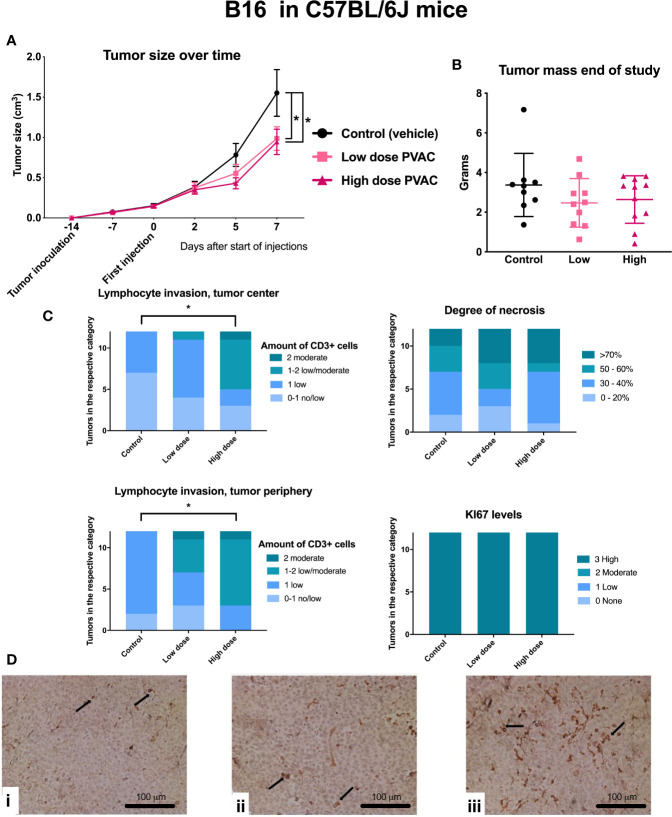
C57BL/6J mice were inoculated with B16.F10 tumor cells and subsequently intratumorally treated with polyvinyl alcohol carbazate (PVAC) (either low dose 0.5 mg/ml or high dose 10 mg/ml) or vehicle. (A) Injections performed on days 0, 2, 5, and 7. Five days after the first injection, tumor size was smaller in the high dose PVAC group compared to control (p < 0.05 mean 0.34 cm3, CI 95% 0.01–0.69). On day 7 the tumor size was smaller in both low dose and high dose PVAC groups (p < 0.05 mean 0.6 cm3 CI 95% 0.27–0.95 and p < 0.05 mean 0.57 cm3 CI 95% 0.22–0.92 respectively). (B) Shows tumor mass at the end of the study after tumor excision. Tumor mass showed a reduction trend. (C) Scoring of histological features, CD3 and Ki-67 staining. The number of CD3+ cells were higher in the high dose PVAC group compared to the control group both in the tumor center (p < 0.05 mean 1.42 rank difference CI 95% 1.09–1.74 vs. 2.42 CI 95% 1.78–3.05) and periphery (p < 0.05 mean 1.83 rank difference CI 95% 1.59–2.08 vs. 2.47 CI 95% 2.47–3.2). (D) displays histology of tumors stained with CD3: i control (vehicle), ii low dose PVAC, iii high dose PVAC.